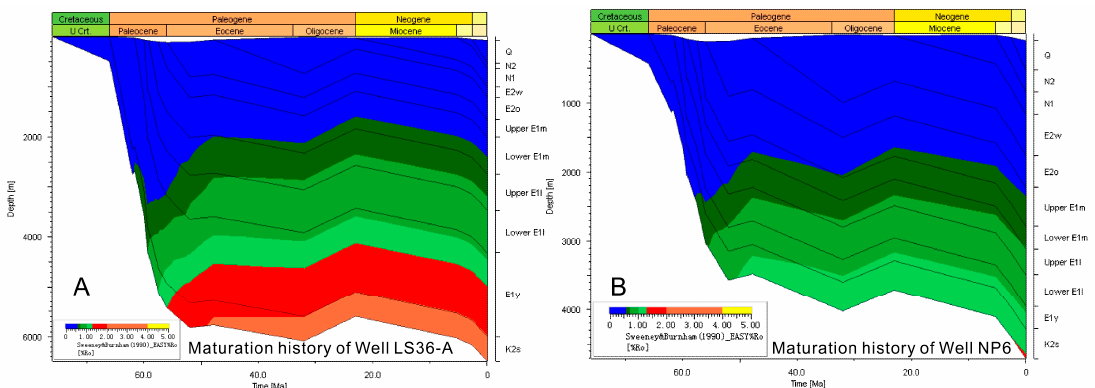
Figure 14. ( A ) Modelled maturity maps at present day for the E 1 y; ( B ) Modelled maturity maps for the Lower E 1 l; ( C ) Modelled maturity maps for the Upper E 1 l. The higher maturities have been reached Figure 15. ( A ) Maturation and burial history of the Well LS36-A in the west sub-sag of the Lishui Sag. in the central part of the west sub-sag. The missing area between the sub-sags represents the Lingfeng ( B ) Maturation and burial history of the Well NP6 in the east sub-sag of the Lishui Sag. Uplift.